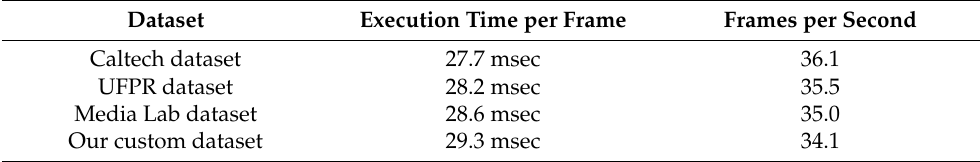
Table 7. The computational efficiency of the proposed system on different